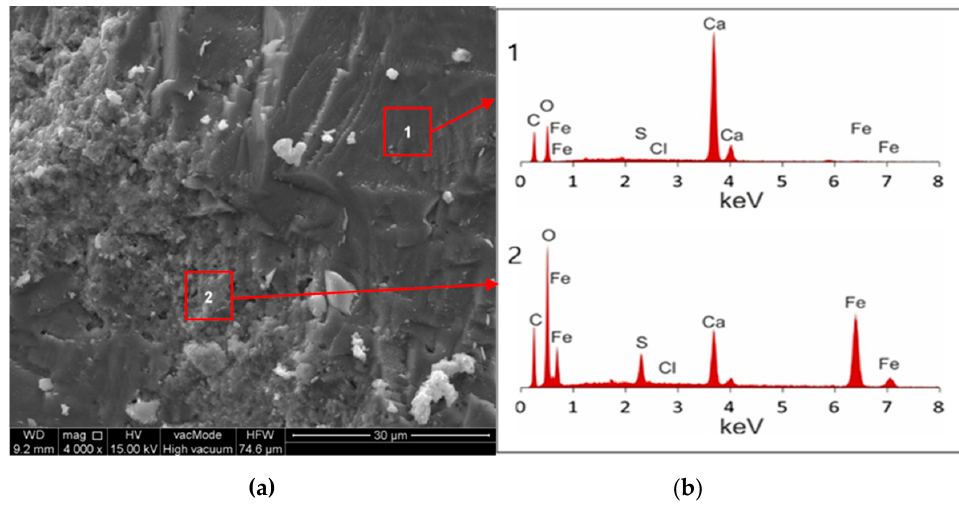
Figure 9. Morphology of the outer layer of the sediment on a corroded cast-iron pipe: ( a ) SEM micrograph; ( b ) spectrum of chemical composition (EDS) of the sediment in points 1 and 2.